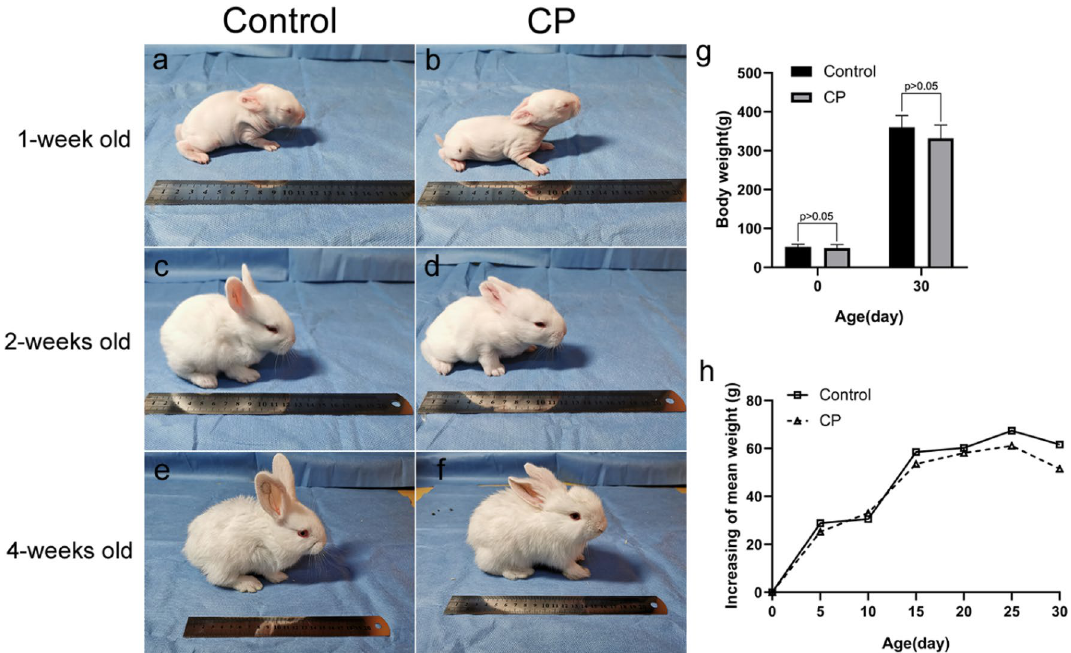
Figure 2. Appearance changes (left) of the control group ( a , c , e ) and the CP (cleft palate) group ( b , d , f ) at week 1 ( a , b ), 2 ( c , d ), and 4 ( e , f ), and the length of the ruler is 20 cm. The body weight changes and comparison (right) between the two groups ( g , h ). There was no significant difference in the weight of the two groups at birth and 1 month old ( p > 0.05) ( g ). The change pattern of the mean weight gaining every 5 days was basically the same between the two groups within 1 month old ( h